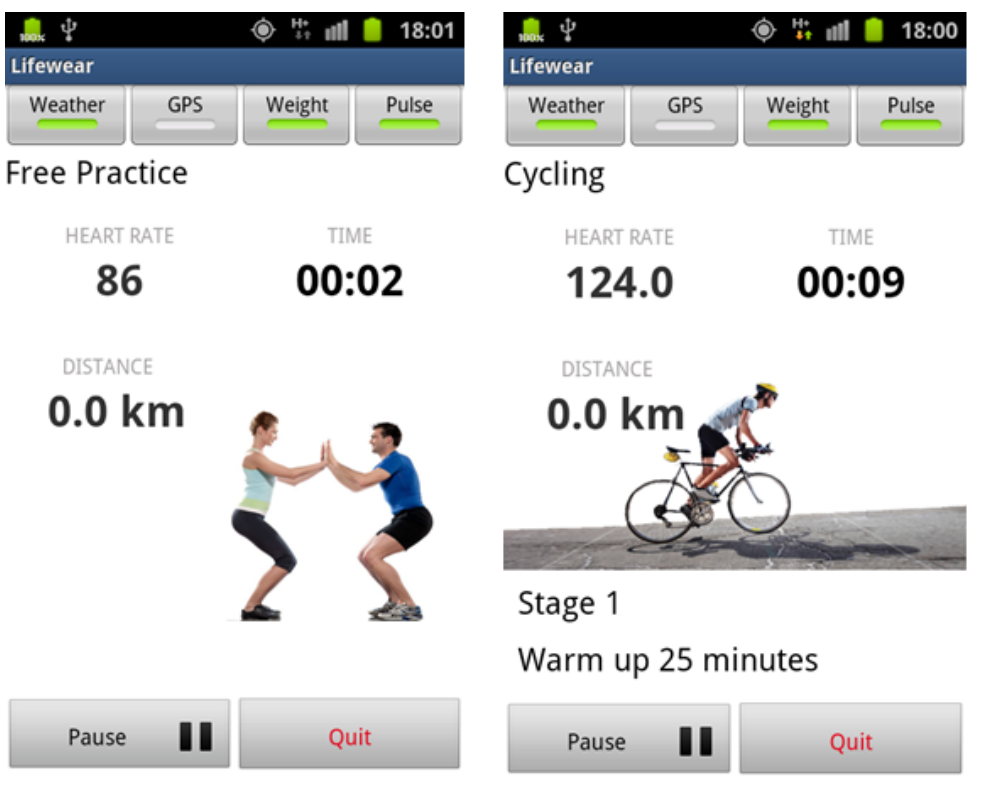
Figure 12. Graphic User Interface of the Lifewear mobile application. Real time data.